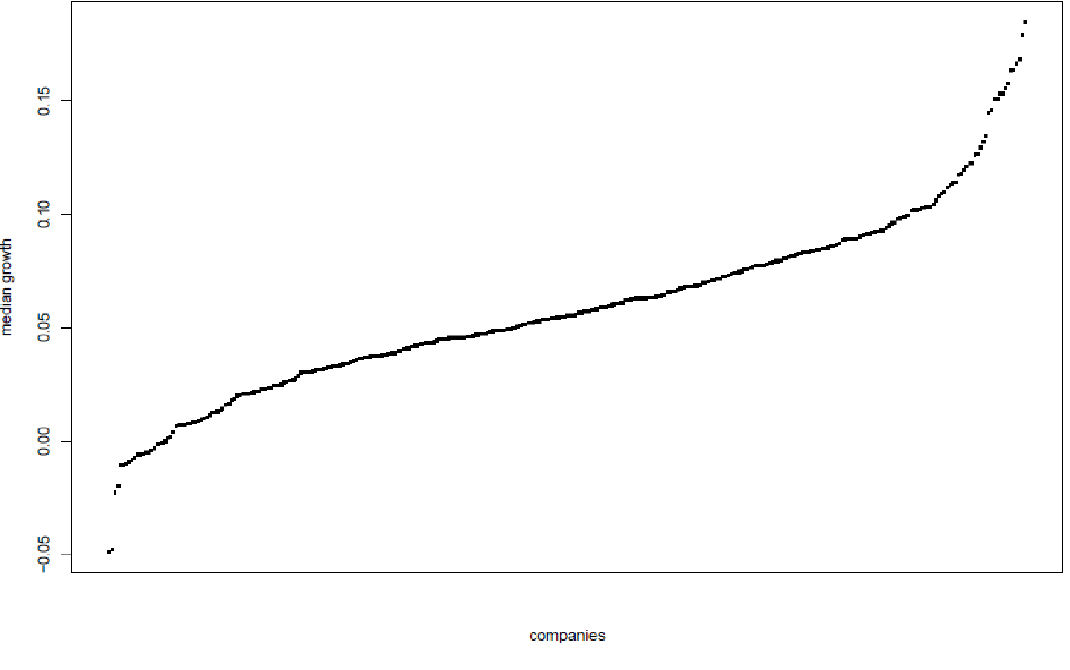
Source : elaboration from Fortune 500